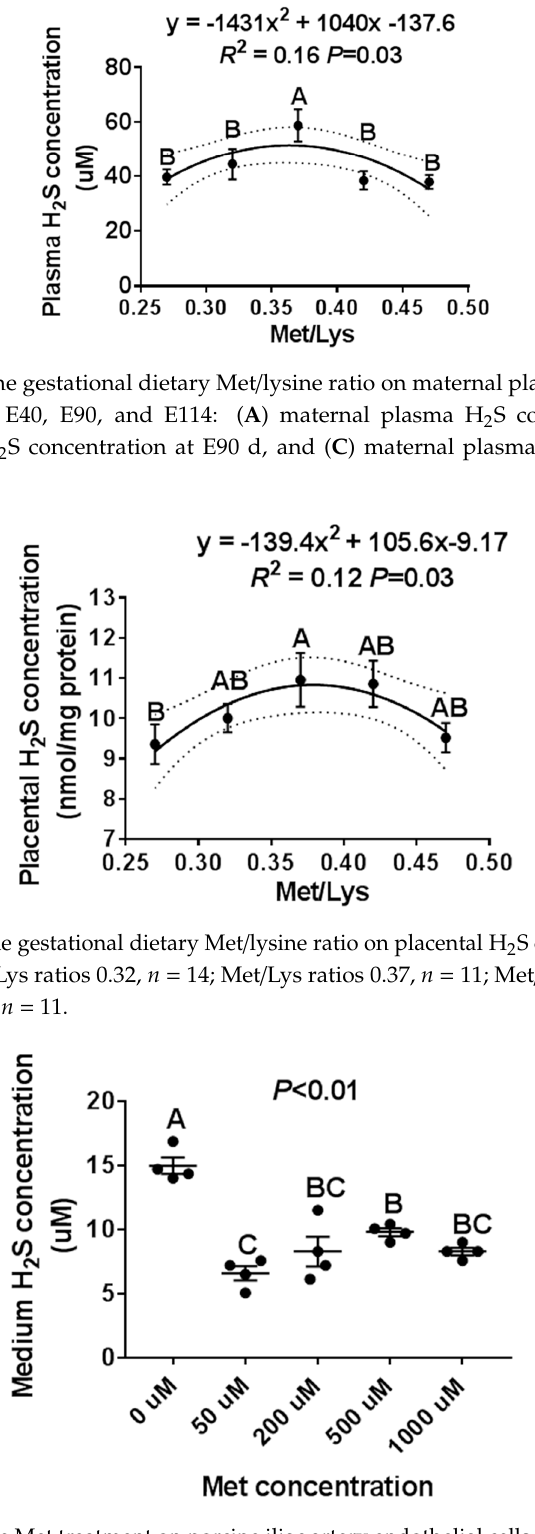
Figure 3. The e ff ect of the Met treatment on porcine iliac artery endothelial cells (PIEC) H 2 S production. The PIEC cells were seeded in a 12-well cell plate. After 80% confluence, the PIEC cells were placed in a serum-free medium for 18 h, followed by a Met-free RPMI 1640 medium for another 6 h, then treated with Met for 24 h. The supernatant culture medium was collected for H 2 S assay, n = 4 /